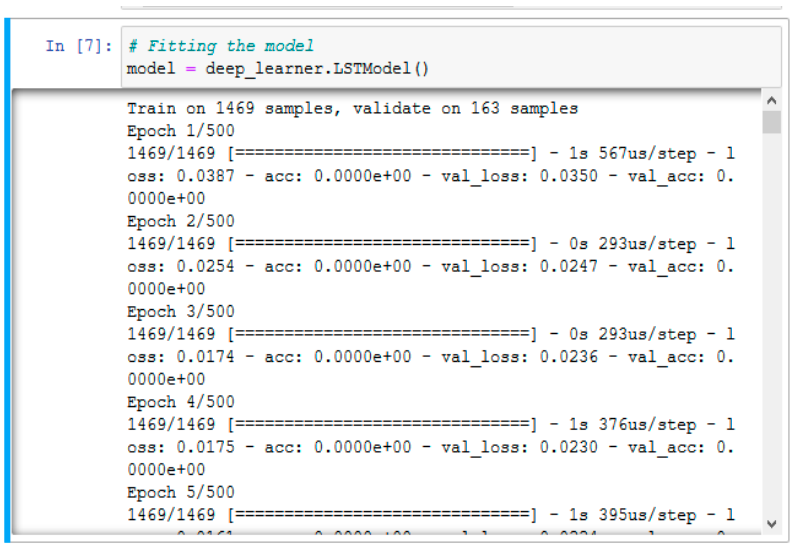
Figure A1. ( a ) Components of the energy monitor system. ( b ) CT coupled in a distribution board of a residential home. Data collected in cloud are processed by the SARIMA and LSTM algorithms. In Figure A2 is illustrated the testing framework used for the algorithm optimization.